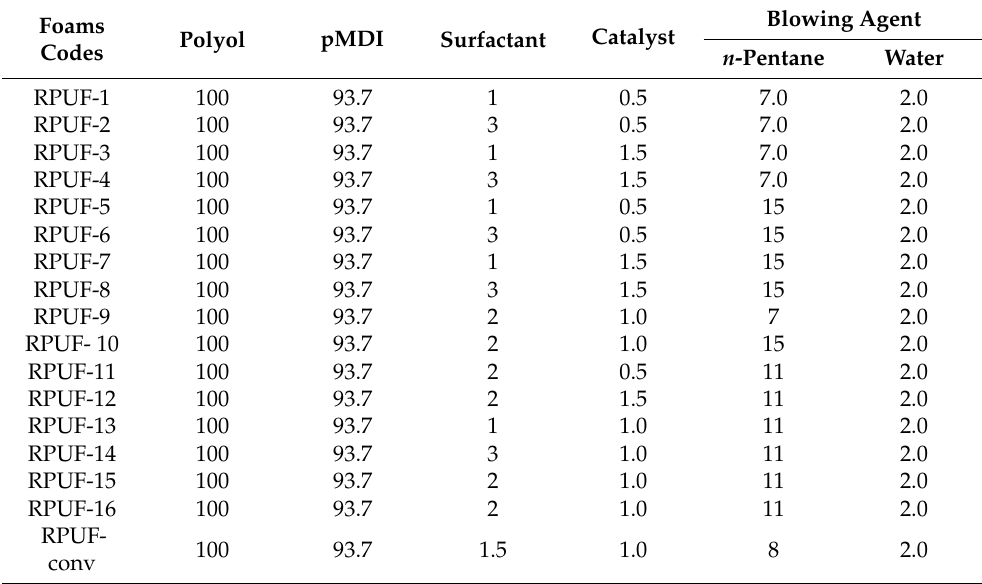
Table 1. Formulations of the RPUFs based on parts per hundred of polyol by weight (php).